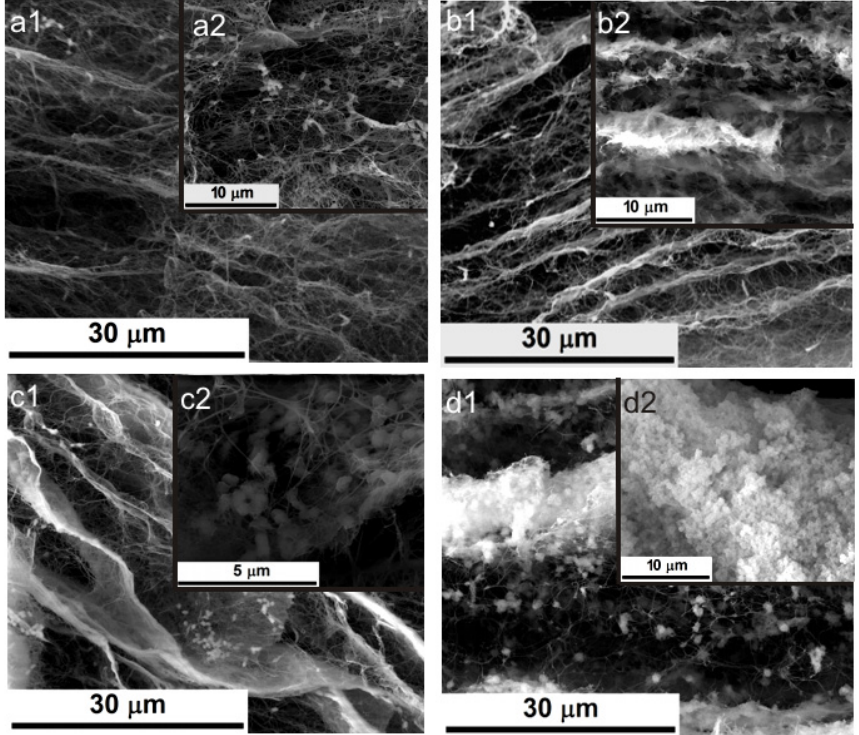
Figure 2 . SEM images of native BC ‐ PC1 ( a1 , a2 ), BC ‐ PC2 ( b1 , b2 ), DABC ‐ CP1 ( c1 , c2 ) and DABC ‐ CP2 ( d1 , d2 ) at different magnifications.